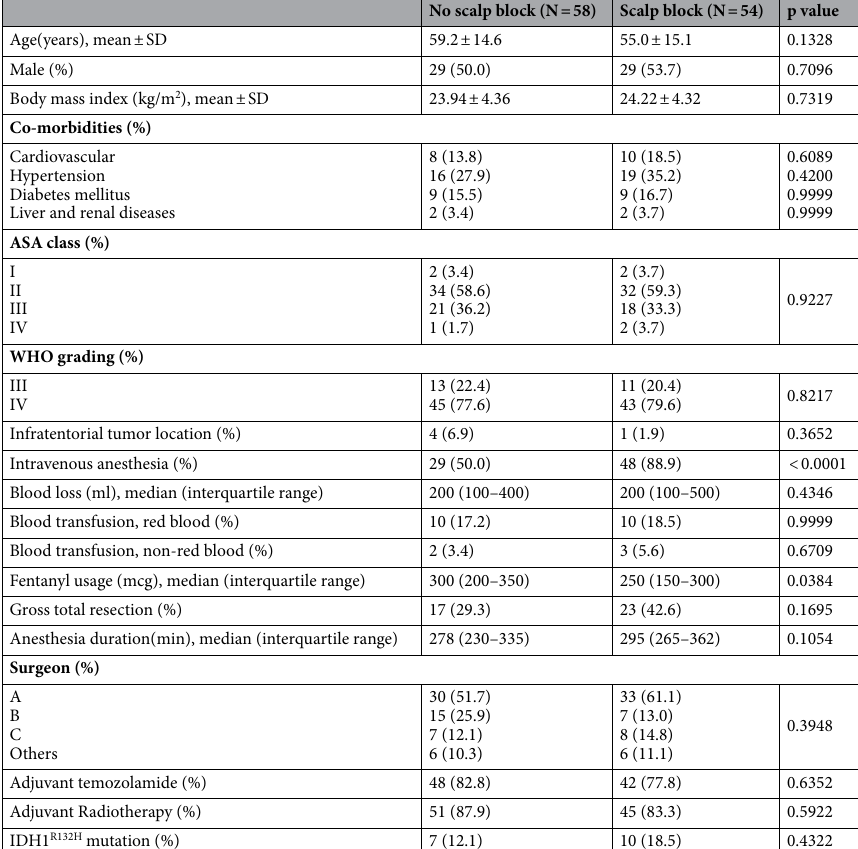
Table 1. Characteristics of patients who received scalp block and those who did not receive scalp block. ASA American Society of Anesthesiologists, WHO World Health Organization, IDH mutation: isohydrate